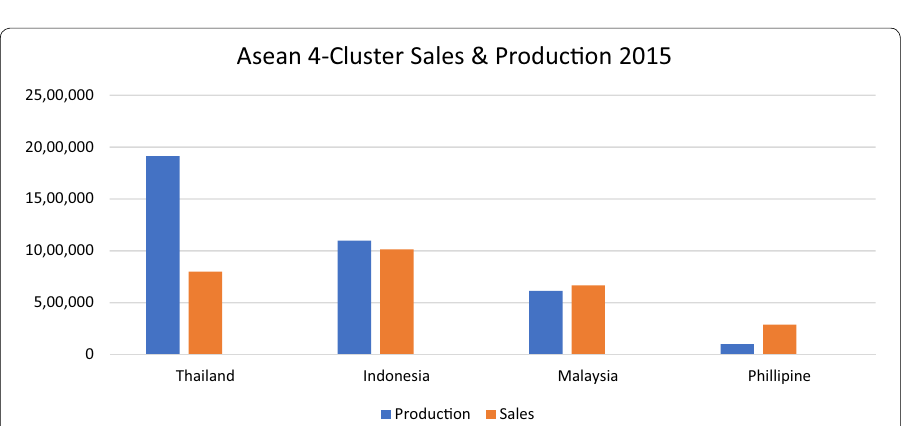
Fig. 2 ASEAN-4 Cluster sales and production 2015. Source : Association of Indonesia Automotive Industries (GAIKINDO)